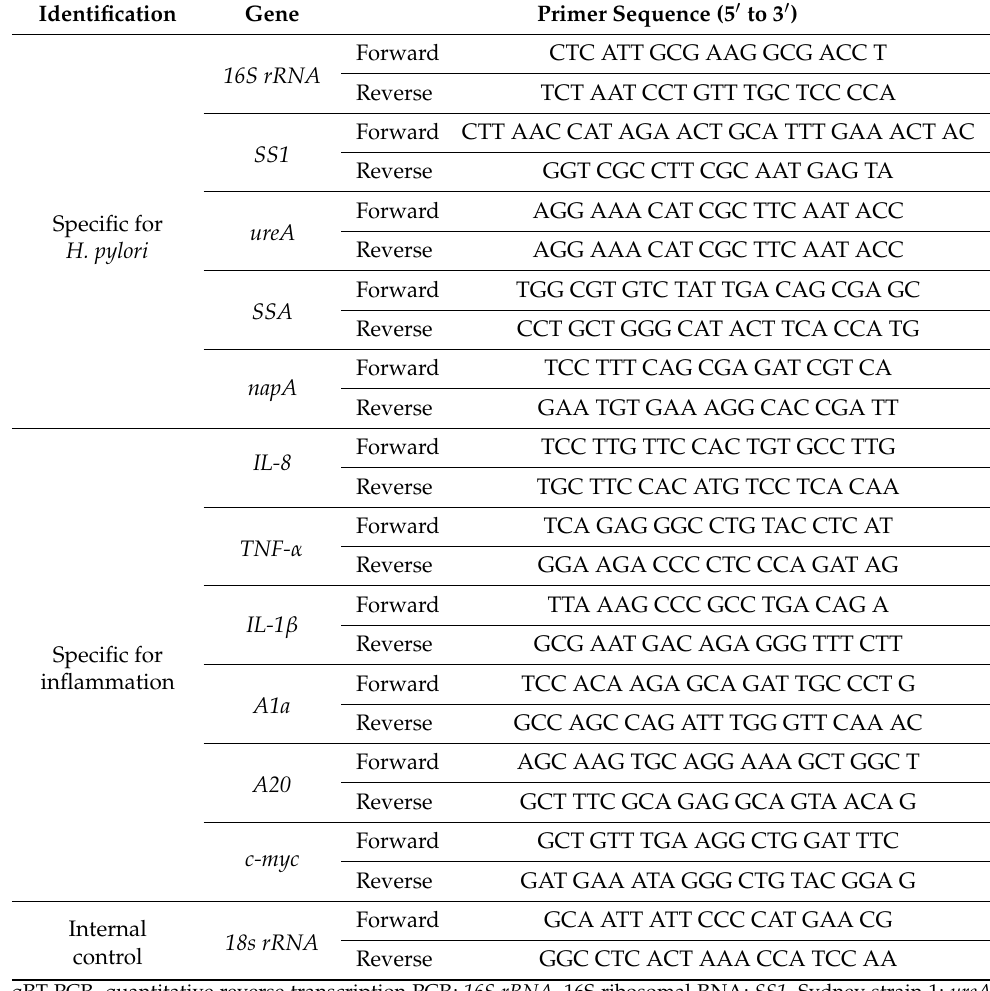
Table 1. Mouse Primer sequences used for qRT-PCR.